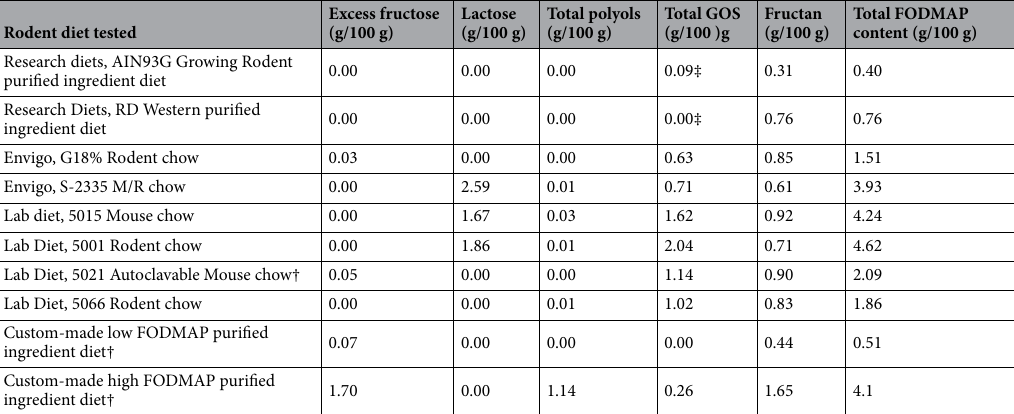
Table 2. FODMAP content of the commercially available and custom-made rodent diets. All samples analyzed as n = 3 except those marked with † denoting analysis as n = 1. Excess fructose is calculated by subtracting glucose content from fructose content. Total polyols is calculated as the sum of sorbitol and mannitol. Total GOS is calculated as the sum of raffinose and stachyose except where indicated ‡, as these samples contained maltodextrin or other ingredients which interferes with the analysis, hence total GOS was analyzed via a GOS enzyme kit. FODMAP denotes fermentable oligosaccharides, disaccharides, monosaccharides and polyols. GOS denotes